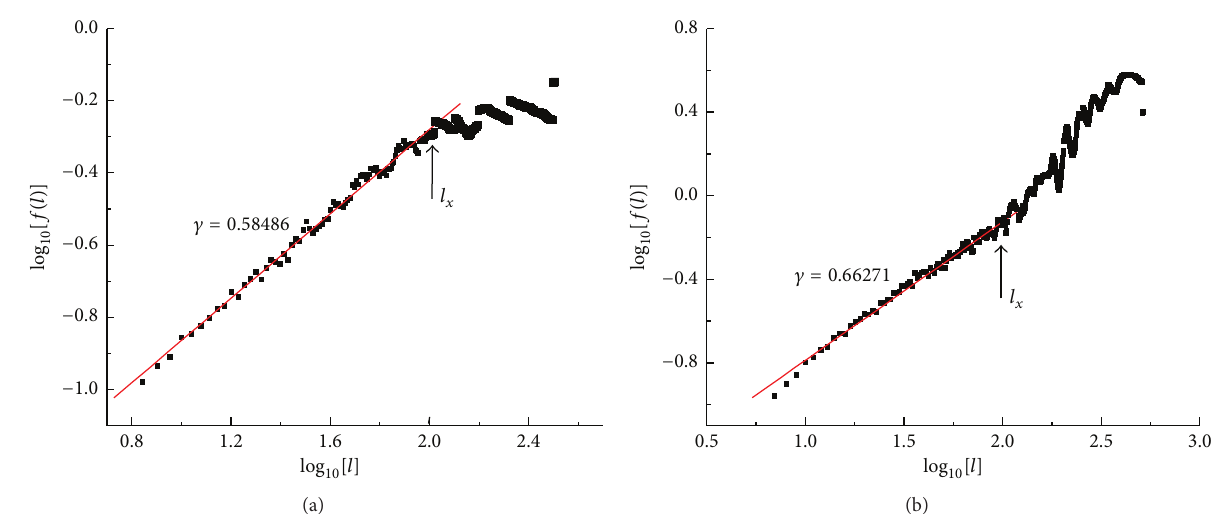
Figure 4: DFA2 curves for two tree-ring width chronologies: (a) Huashan pines on the western peak of the Huashan Mountains and (b) Qilian junipers in the De Halin